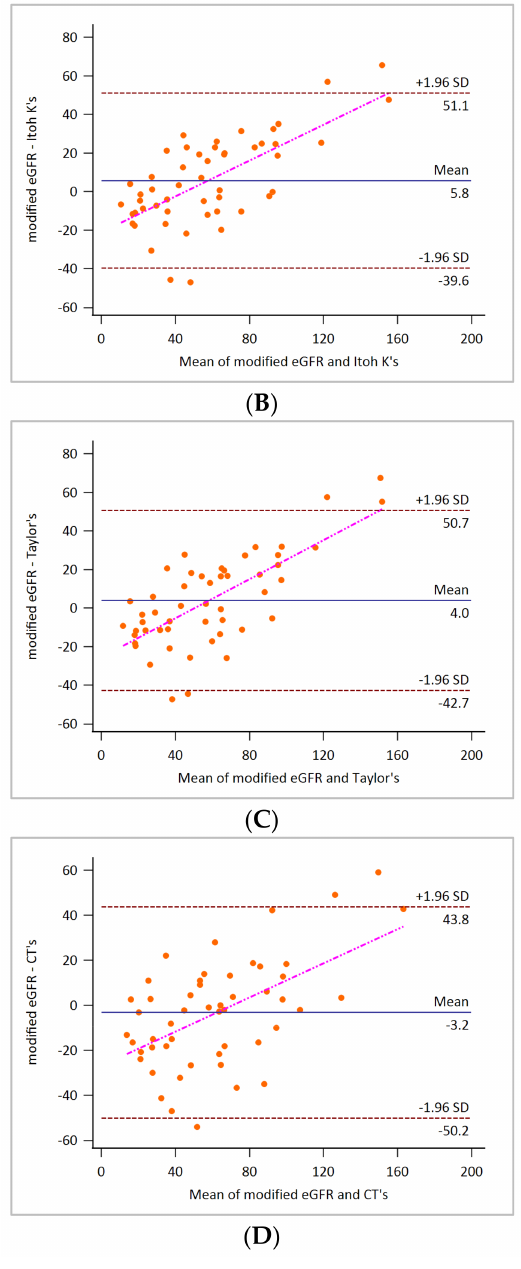
Figure 4. The Bland–Altman plot for GFRs calculated through four methods and the modified eGFR. ( A ), GFR calculated by Tonnesen’s formula ( p = 0.0001). ( B ), GFR calculated by Itoh K’s formula ( p = 0.0818). ( C ), GFR calculated by Taylor’s formula ( p = 0.2355). ( D ), GFR calculated by CT scan ( p =